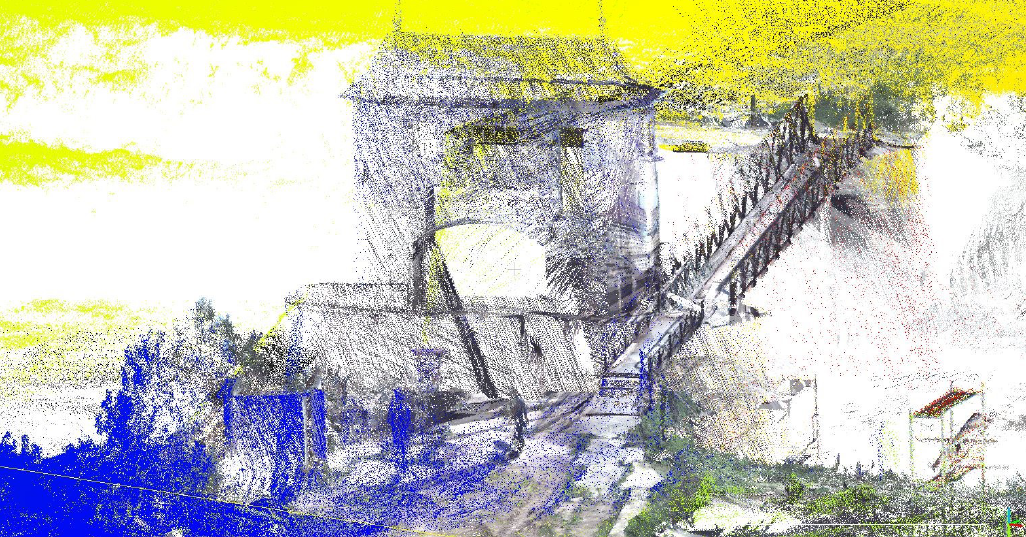
Figure 14. LiDAR data obtained by Velodyne VLP16 scanning at Sânmihaiu Român.